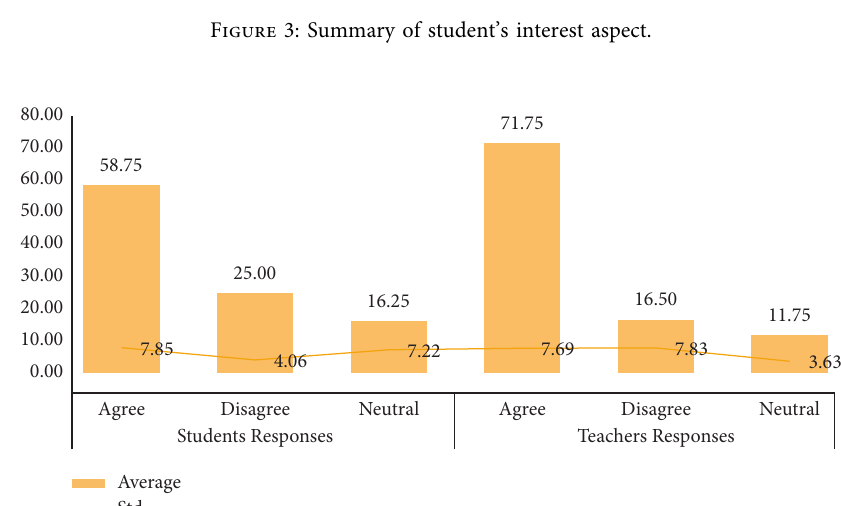
Figure 3: Summary of student’s interest aspect.